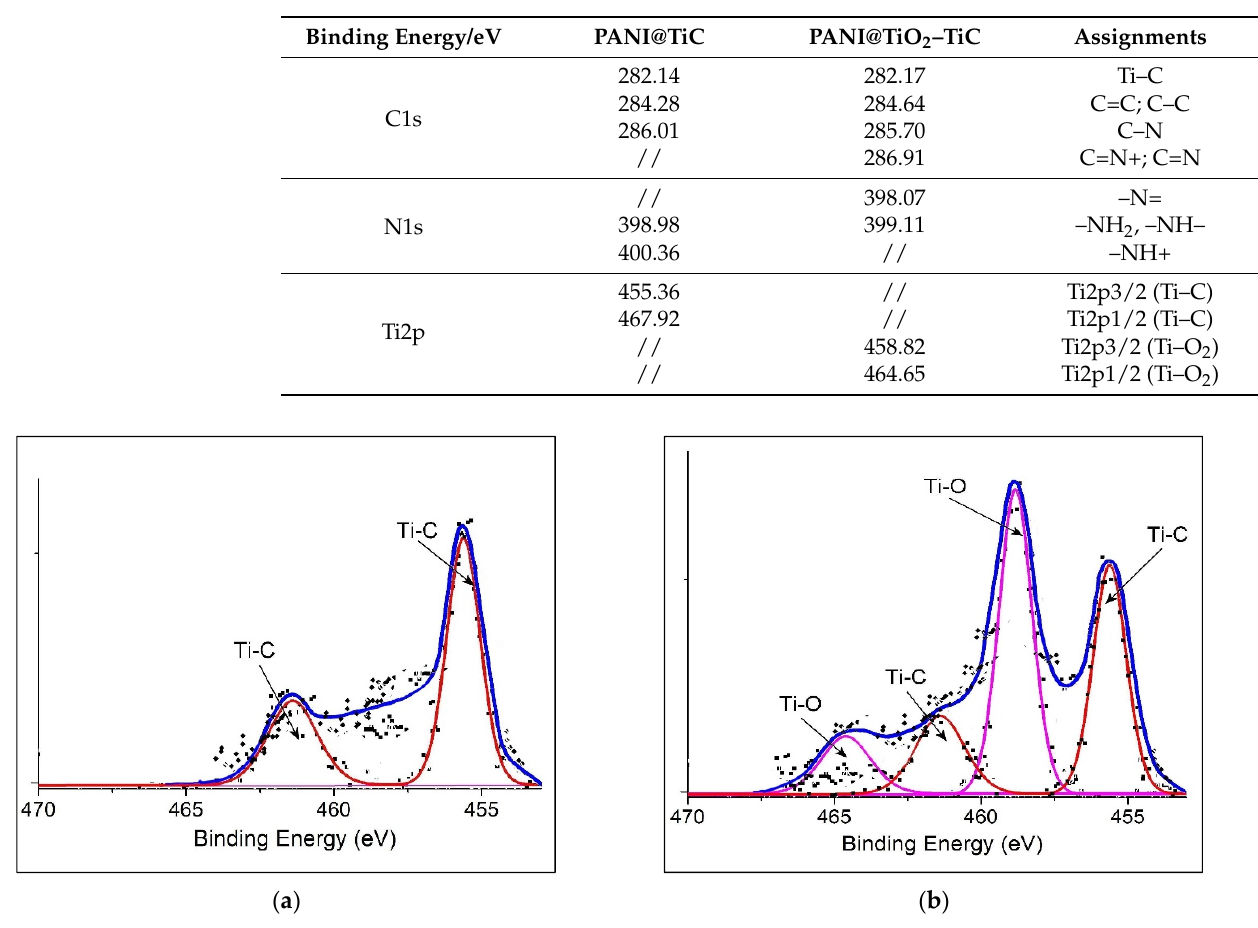
Table 1. Summary of the XPS binding energy values (eV) obtained for hybrid materials.